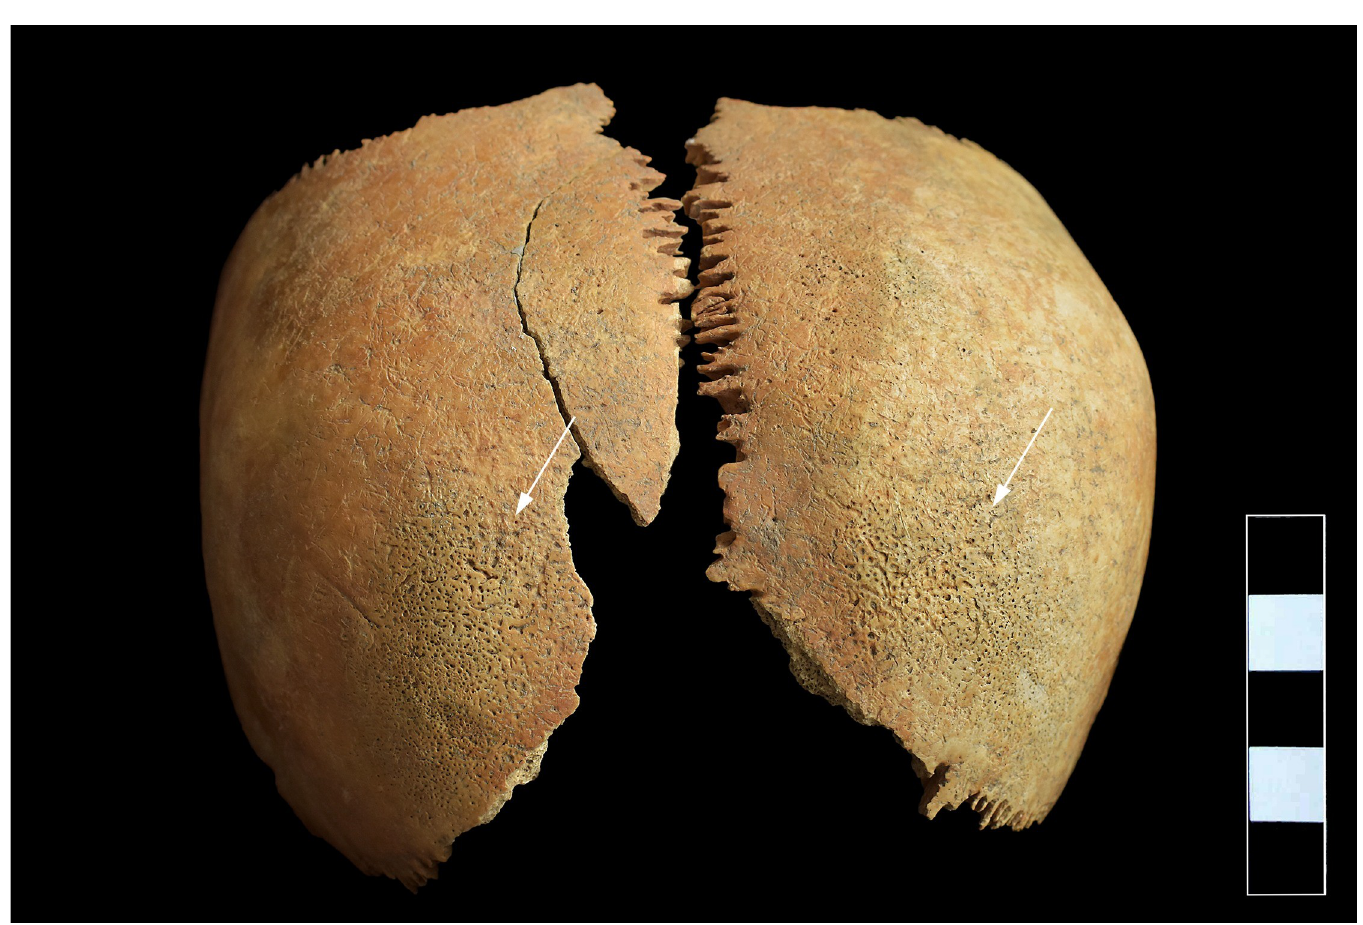
Fig 3. Signs of cribra cranii on the ectocranial surface of both parietal bones (white arrows).